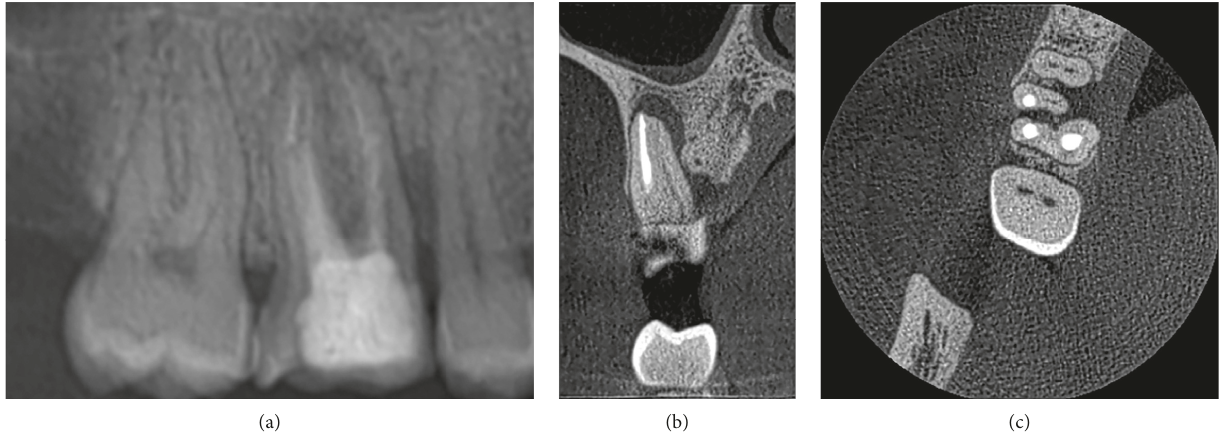
Figure 1: Endodontic treatment 1.6. (a) Periapical X-ray: apex endodontic treatment and periapical radiolucency. (b) CBCT sagittal section: apex endodontic treatment MB, untreated MB2, and periapical radiolucency. (c) CBCT transversal section: untreated MB2.